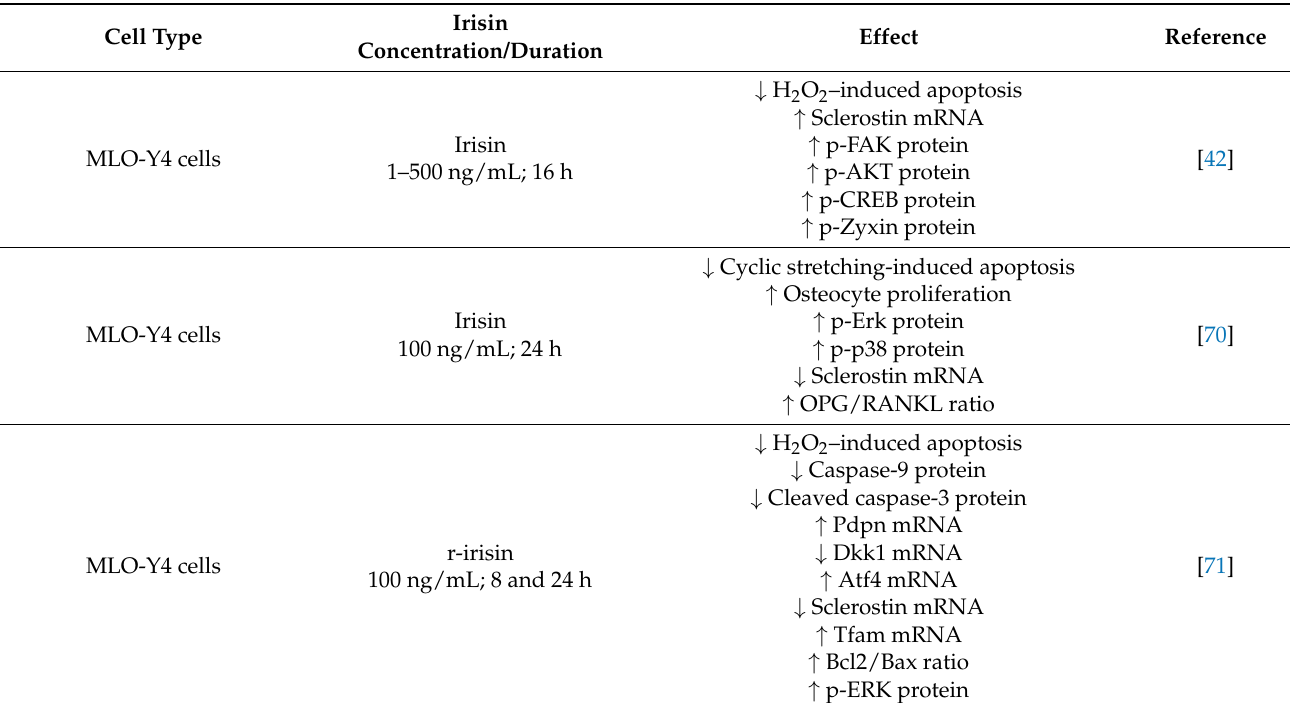
Table 3. Role of Irisin on Osteocytes: in vitro